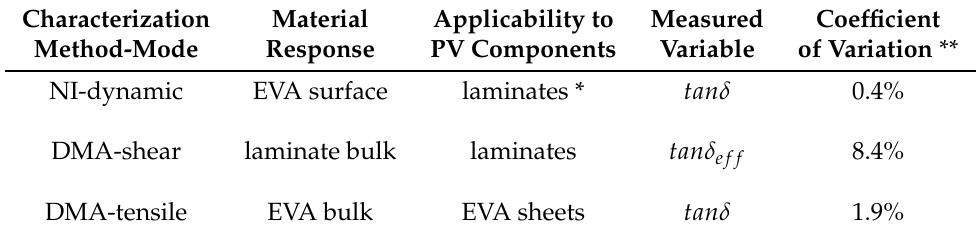
Table 4. Comparative summary of the investigated approaches and their correlation to